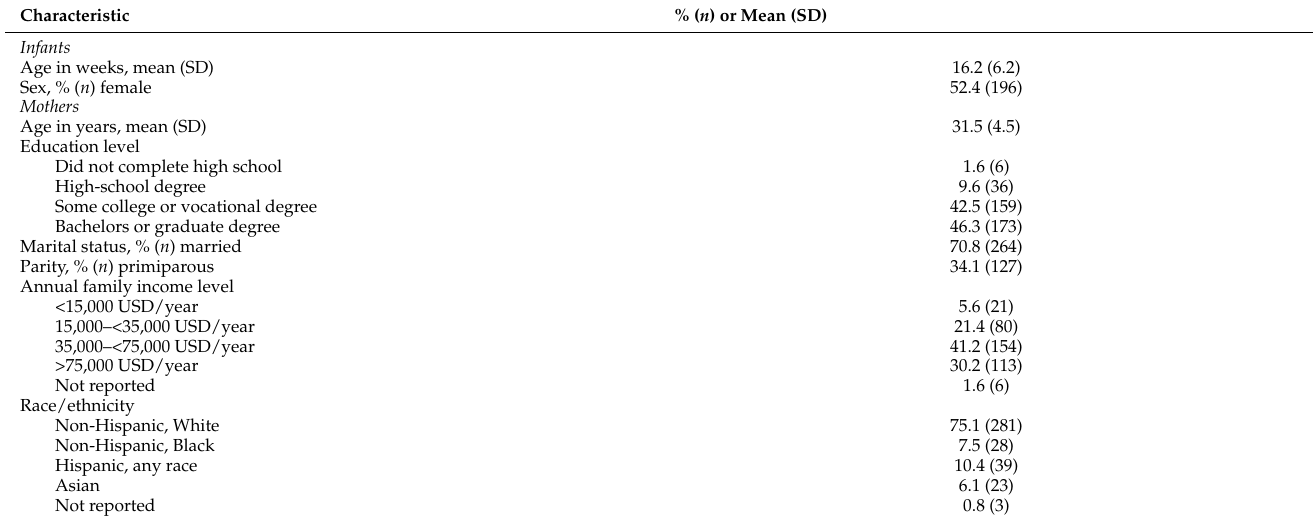
Table 1. Sample characteristics ( n =